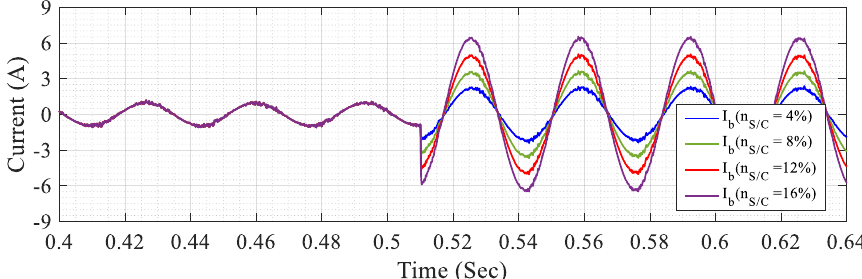
Figure 8. The instantaneous currents of phase A in case of inter-turn fault at 0.72 A load and 30 Hz frequency.